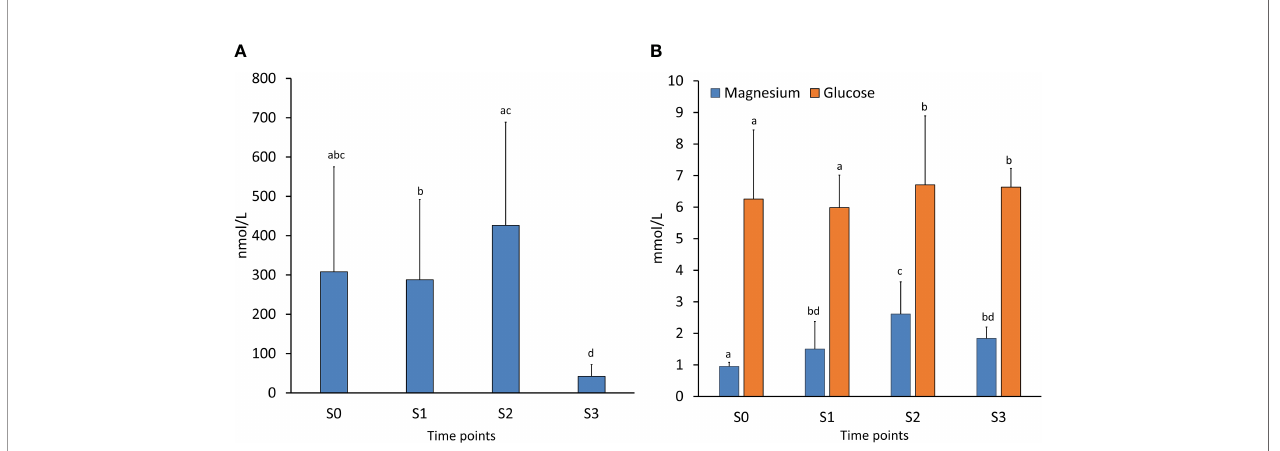
FIGURE 4 | Plasma stress indicators. The levels of (A) cortisol (nmol/l) and (B) magnesium and glucose (mmol/l) were analyzed in the representative fi sh (N=15) during the 3 phases of production. Values are provided as mean ± SD Different letters indicate a signi fi cant difference at P < 0.05, analyzed by Kruskal-Wallis test followed by Conover-Iman post hoc